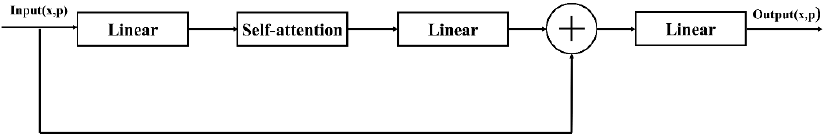
Figure 3. Illustration of how the KPConv interacts with the point cloud. Bottom right corner of the picture shows the position of the kernel points in the sphere.